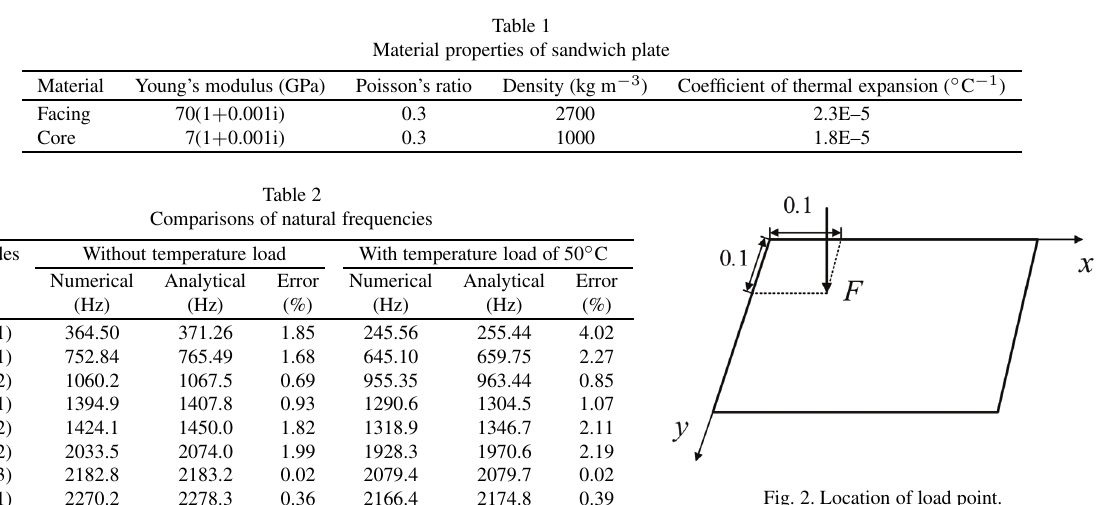
Fig. 2. Location of load